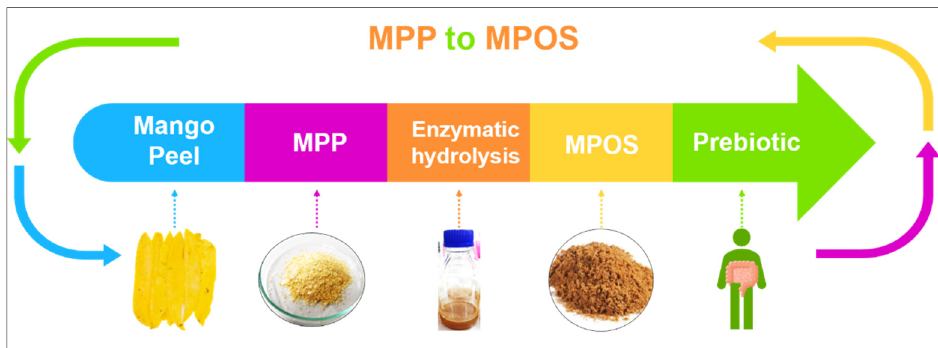
Figure 4. Future direction of MPP utilisation to MPOS production.